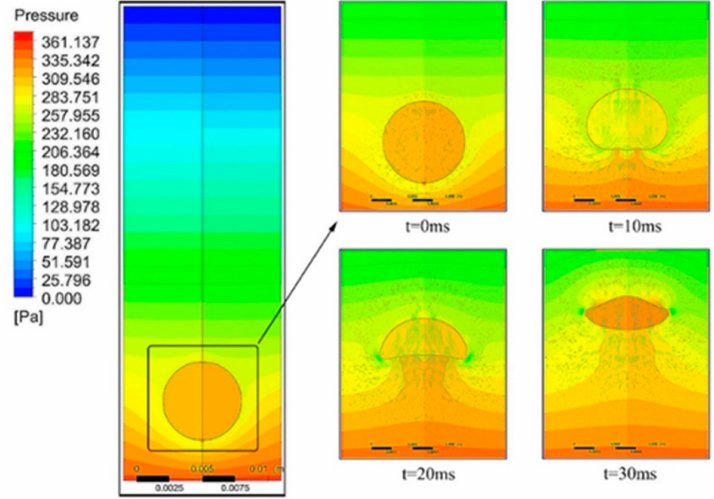
Figure 12. Bubble pressure field cloud